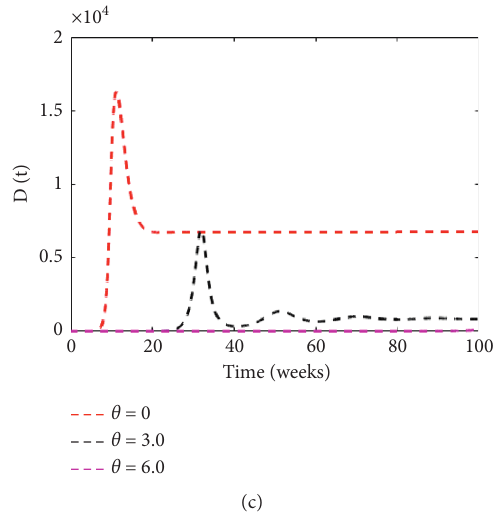
Figure 6: Effects of case detection on Ebola